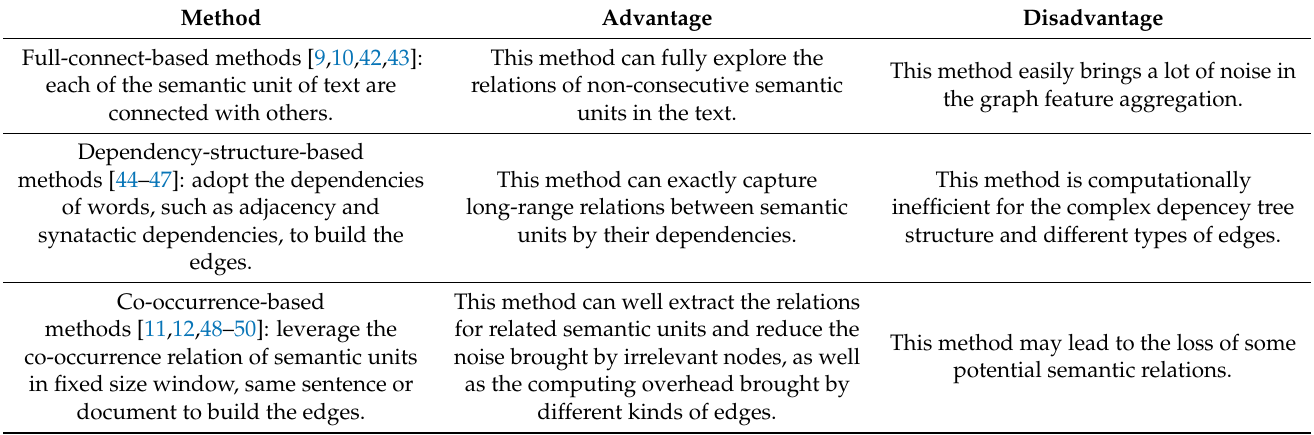
Table 1. Comparison of graph-based semantic representation learning methods. In particular, our model mainly adopts the co-occurrence method to build the entity graph. Differently, we introduce two types of contrastive tasks to further learn the discriminative representations of